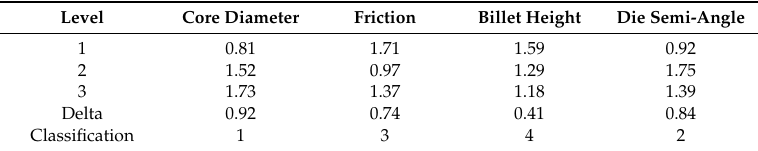
Table 15. Taguchi’s results for the average values for damage